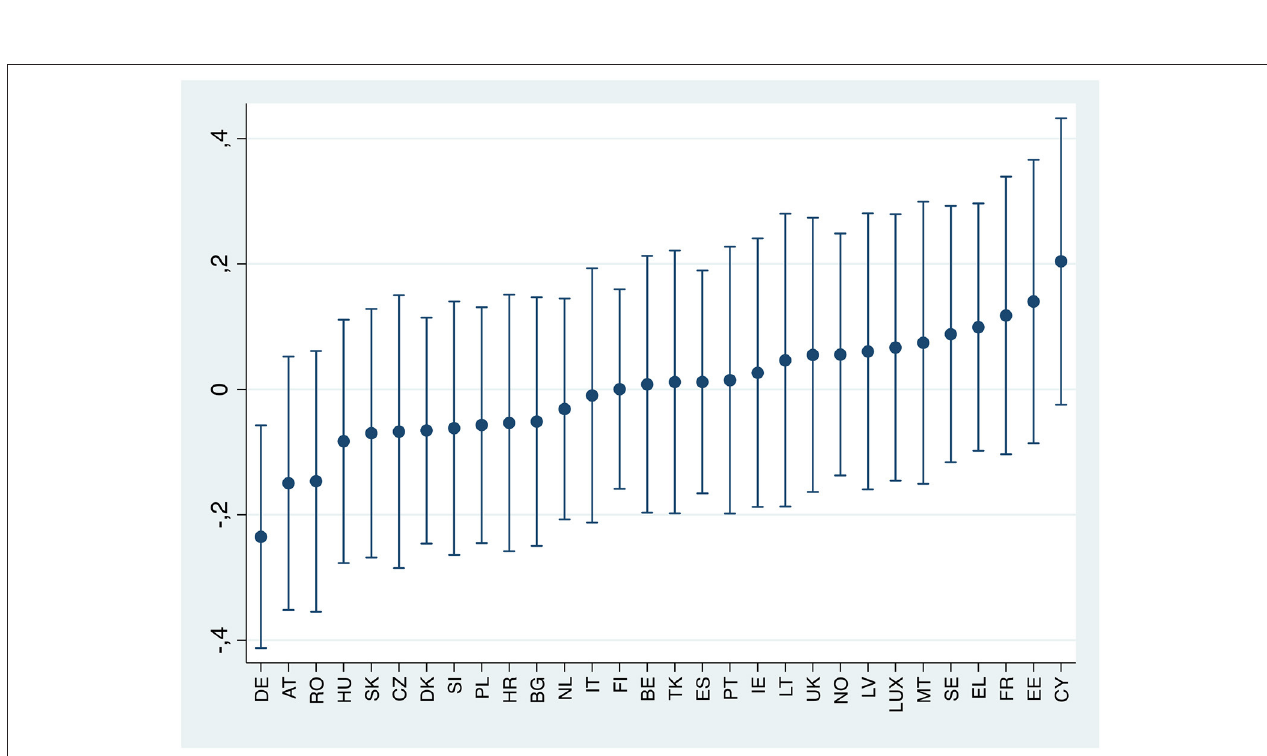
FIGURE 3 | Best linear unbiased predictions of the random effects for perceived job insecurity, by country (male subsample).